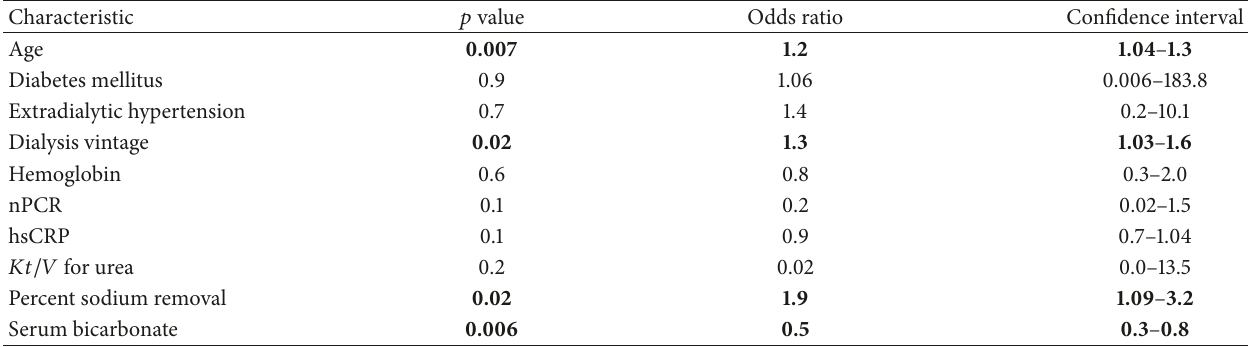
Table 2: Logistic regression model by enter method showing risk factors for demonstration of intradialytic hypertension in our data.